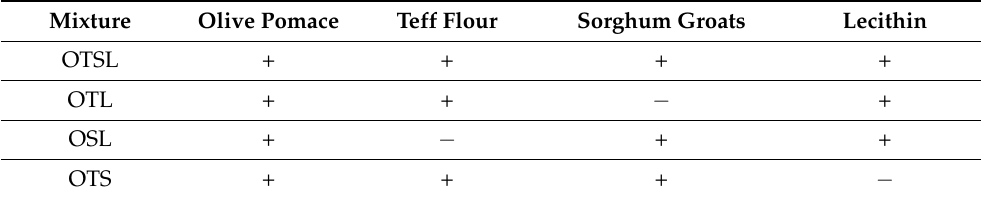
Table 1. Composition of disposable tableware